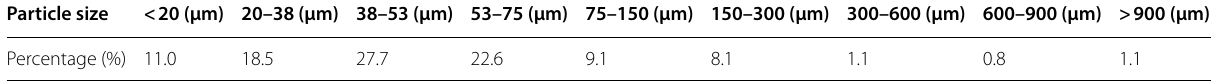
Table 2 Size distribution of waste glass powder (after 50 min milling).